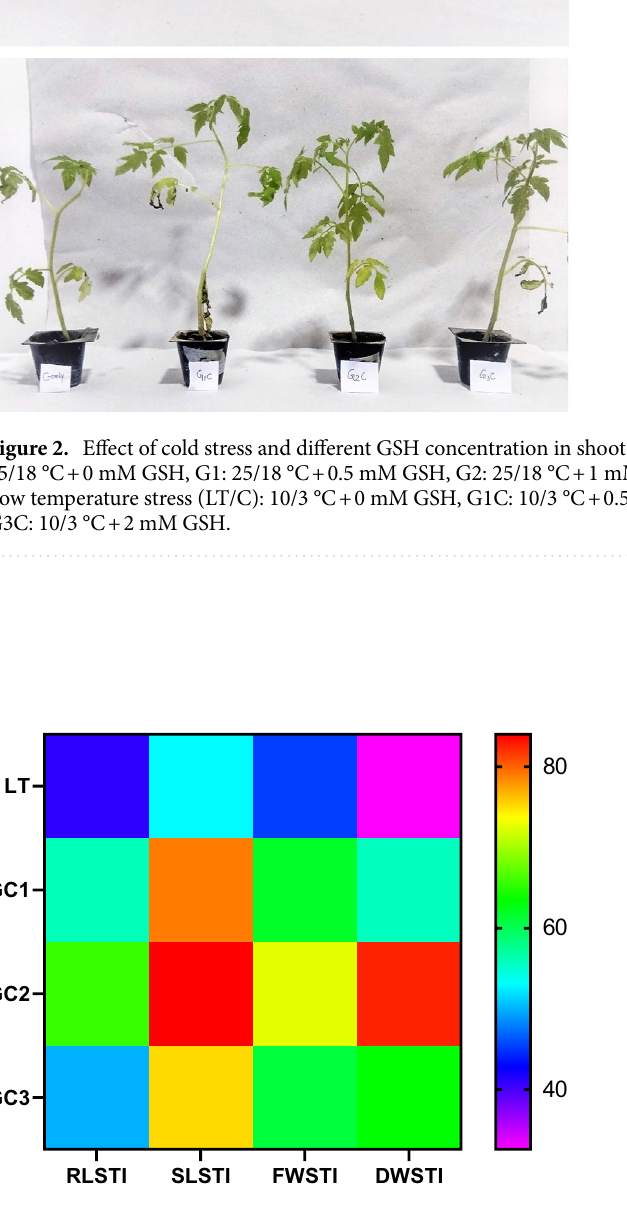
Figure 3. Heat map visualization of STI: Based on different stress tolerance indices (RLSTI, SLSTI, FWSTI and DWSTI) was plotted in color scale, with blue indicating least and red indicating maximum tolerance